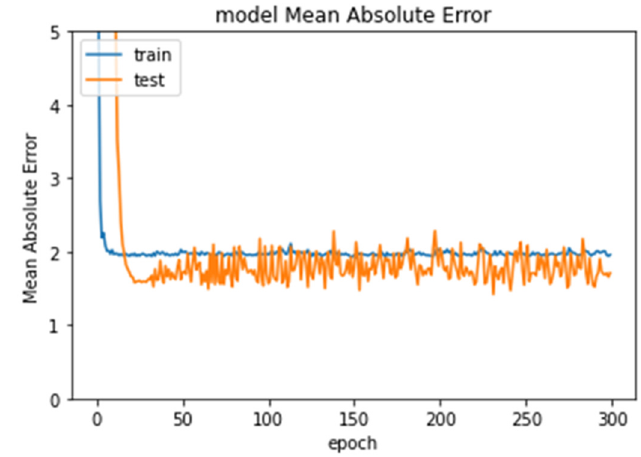
Figure 5. Error rate in Experiment 1 through epochs.